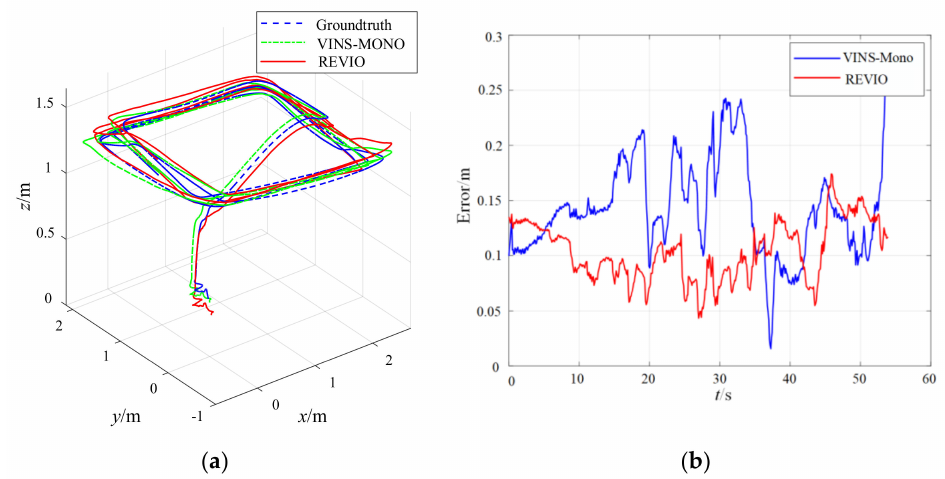
Figure 13. Flying experiment: ( a ) the estimated trajectory of flying experiment; ( b ) the position error in flying